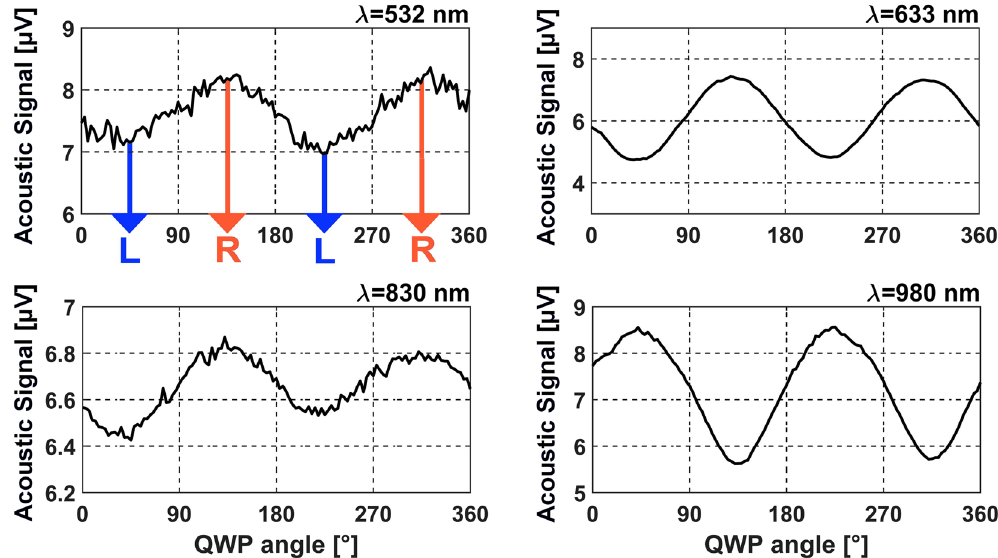
Figure 4. PA signal (in μ V) as a function of the QWP orientation angle for four optical pumps; these spectra have been obtained under downward illumination. Extrapolated CD A values are + 0.14 @ λ = 532 nm, + 0.41 @ λ = 633 nm, + 0.1 @ λ = 830 nm, and − 0.35 @ λ = 980 nm. The sound modulation was set at 25 Hz, and the measurements were performed with a detail of 2 degrees and a time step of 5 seconds between each